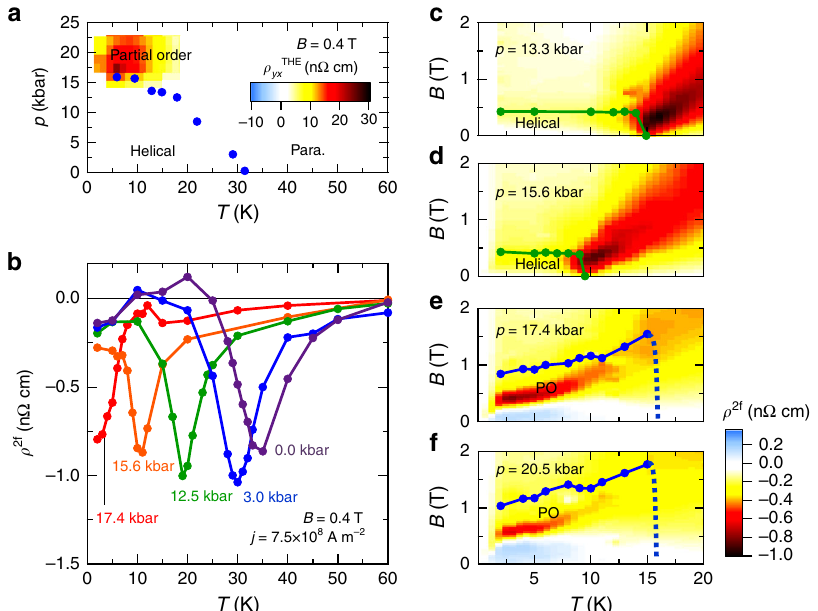
Fig. 4 Pressure effect on electrical magnetochiral effect. a Pressure ( p ) — Temperature ( T ) phase diagram together with contour mapping of observed topological Hall resistivity ρ THE yx at 0.4 T (see Supplementary Fig. 5 and Supplementary Note 6). b Temperature dependence of second harmonic resistivity ( ρ 2f ) for 0.4 T at various pressures in left-handed MnSi. c – f Contour mappings of ρ 2f at various pressures in T - B plane in left-handed MnSi. The green lines are the phase boundary between the conical and induced ferromagnetic phases determined from magnetoresistivity measurements, and the blue lines are the phase boundary of the partial order phase determined from topological Hall effect